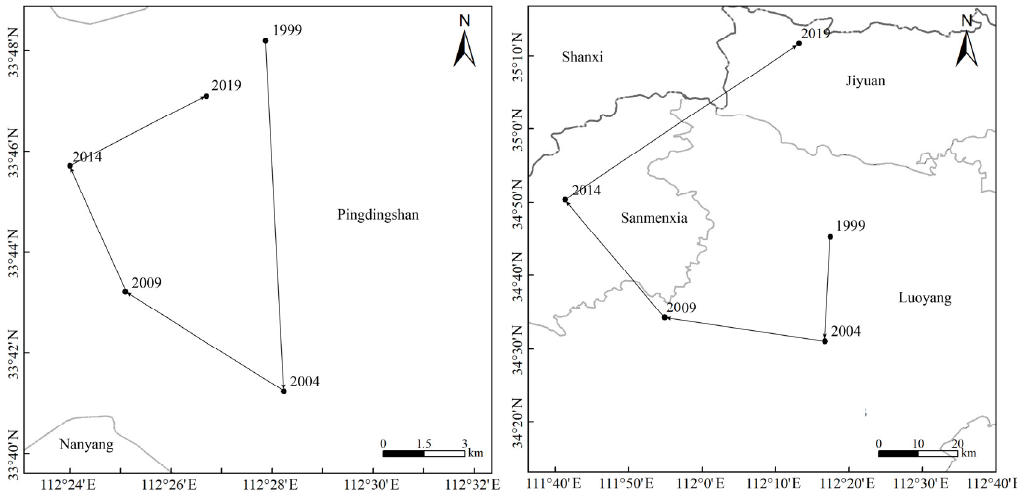
Figure 6. Change of gravity centers of agricultural production efficiency and agricultural carbon emission intensity.